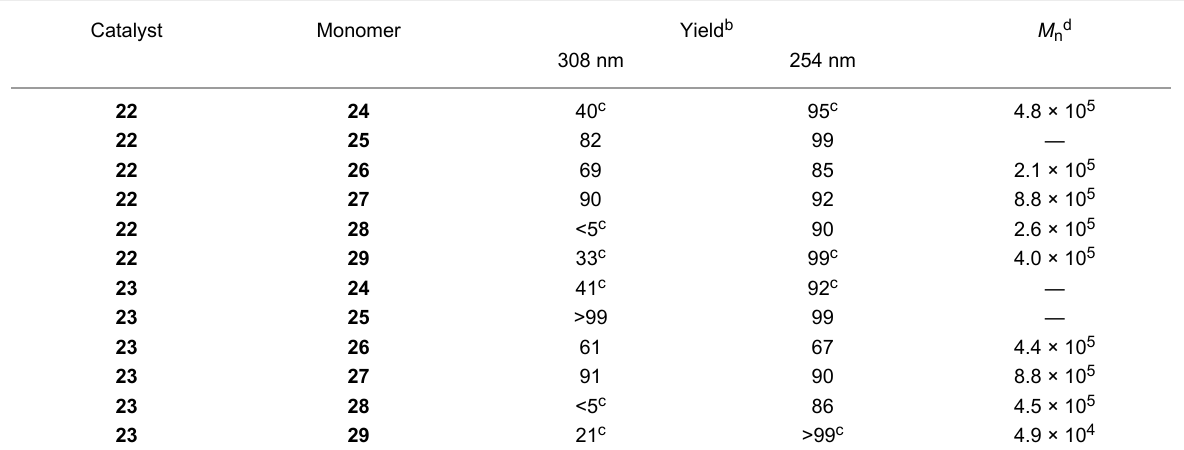
Table 3: Polymerisation results for monomers 24 – 29 by 22 and 23 a . Catalyst